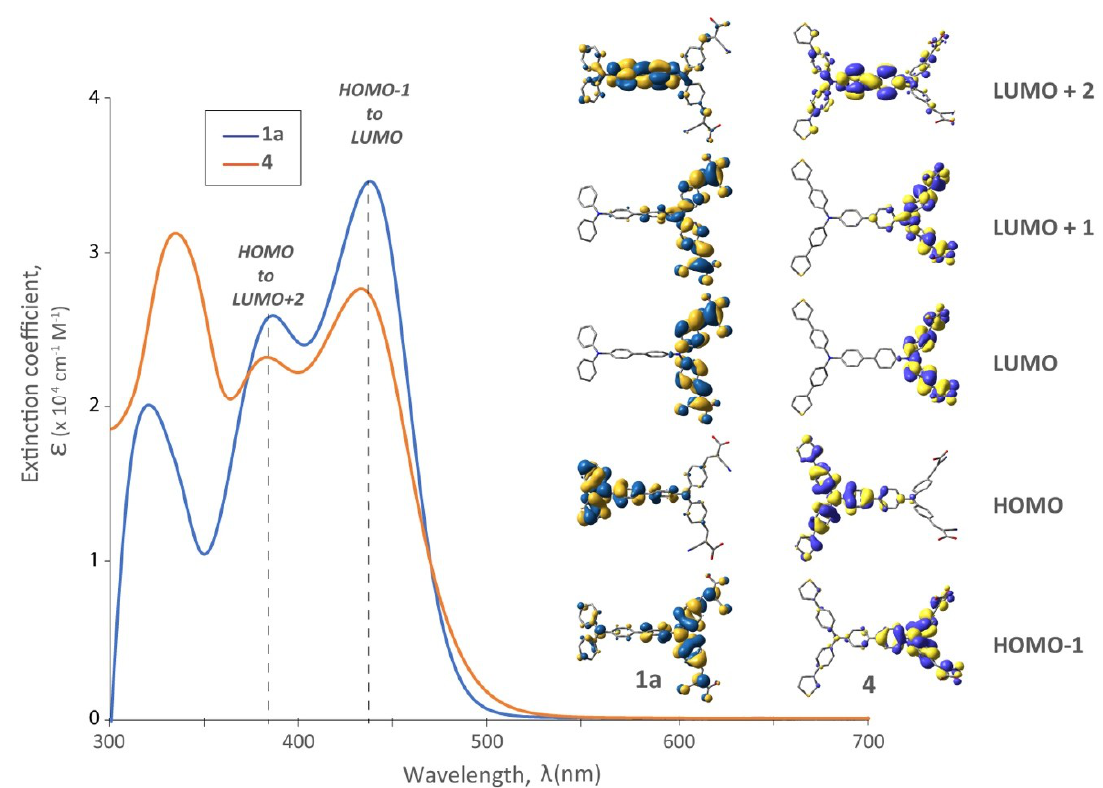
Figure 5. UV-Vis spectra of dye 1a vs. 4 (3-thienyl substituents on distal TPA unit), and their respective DFT frontier orbitals.